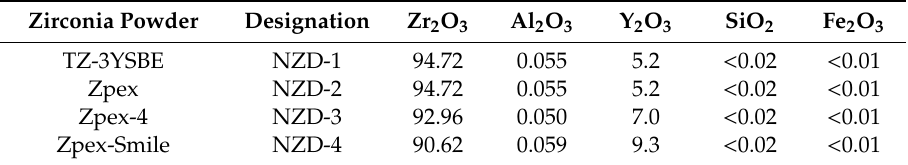
Table 1. Powder chemical composition (in wt %) used to produce the zirconia blocks (according manufacturing